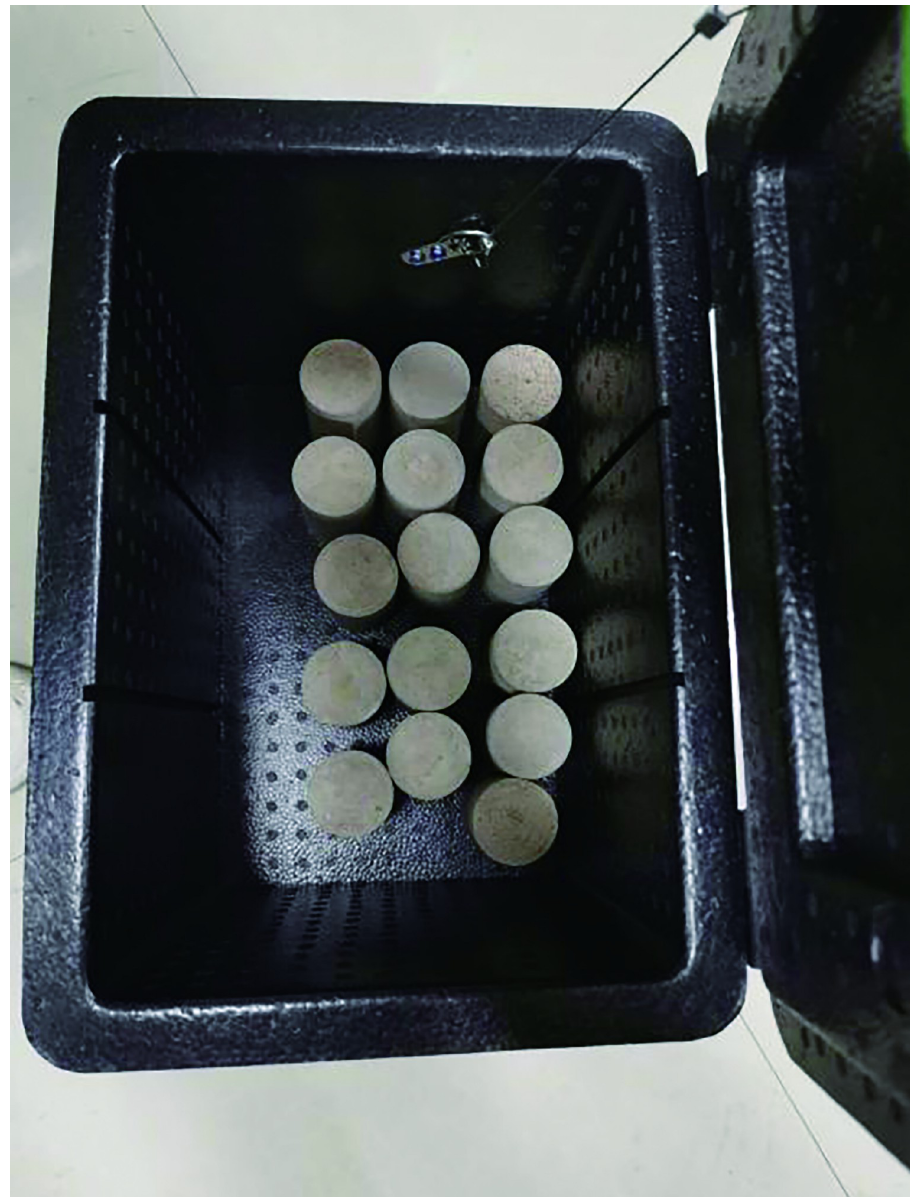
Fig 13. Placement arrangement of specimens in an